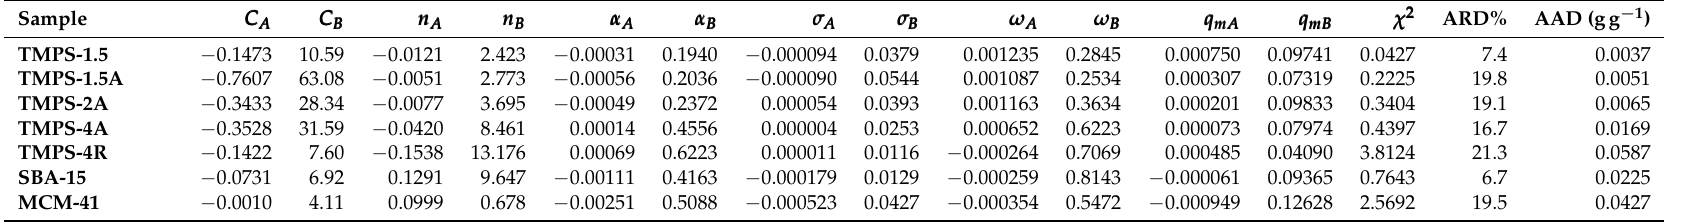
Table 5. mBET+G model’s temperature dependent parameters approximation. Valid temperature region 5 ◦ C to 40 ◦